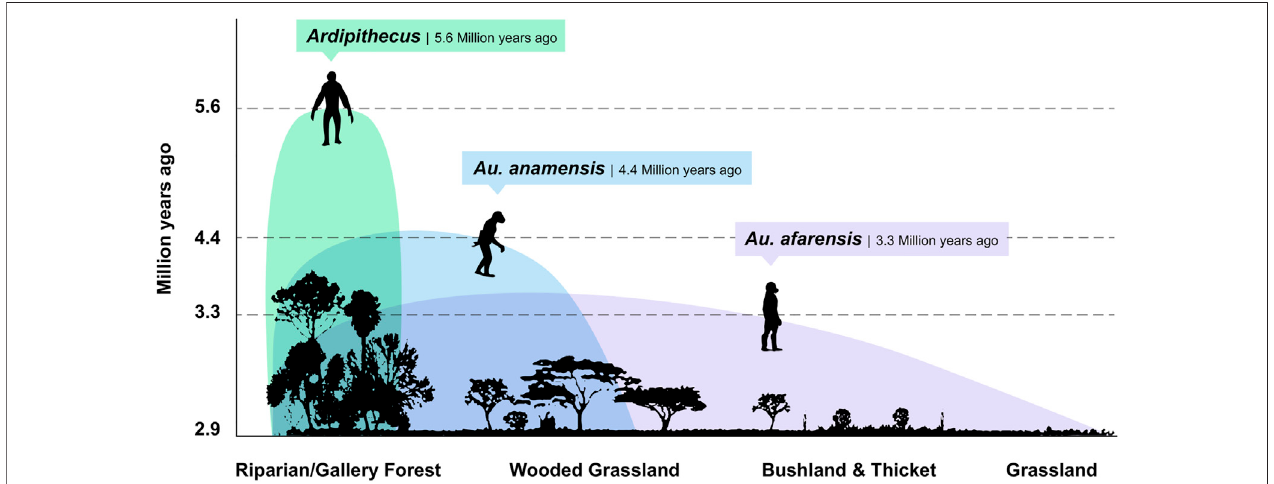
FIGURE4| Eastern Africanhomininpaleoecology. Thepaleoenvironmentalrecord from earlyhominin bearing sites showsecologically diversi fi edlandscapes. The Mio-Pliocene environments of Ardipithecus have been reconstructed as lakeside, mosaic ecosystems that included permanent wetlands, dense woodlands or gallery forests, wooded grasslands, and grasslands, all of which indicate a degree of spatial variability in the proportion of plant type composition and coverage (WoldeGabriel et al., 1994; WoldeGabriel et al., 2001; Levin et al., 2008; White et al., 2009a; White et al., 2009b; Lovejoy et al., 2009; WoldeGabriel et al., 2009; Cerling et al., 2010). Australopithecus anamensis also frequented C 3 dominated, closed canopy riparian or gallery forests within an otherwise dry, open acacia woodland catchment (Leakey et al., 1995; Saylor et al., 2019), while Au. afarensis accessed open grasslands, dry bushlands, and riparian woodlands and forests (Johanson et al., 1982; Andrews,1989).In southern Africa (not shown), Au. africanus likelyhad access toforests,ecotones,wooded grasslands,and grasslands(Rayner et al., 1993;Sloggett, 2016), and Au. sediba made use of C 3 -dominated microhabitats within a regional environment of abundant C 4 grasses ∼ 2.0 Ma (Bamford et al., 2010; Henry et al.,